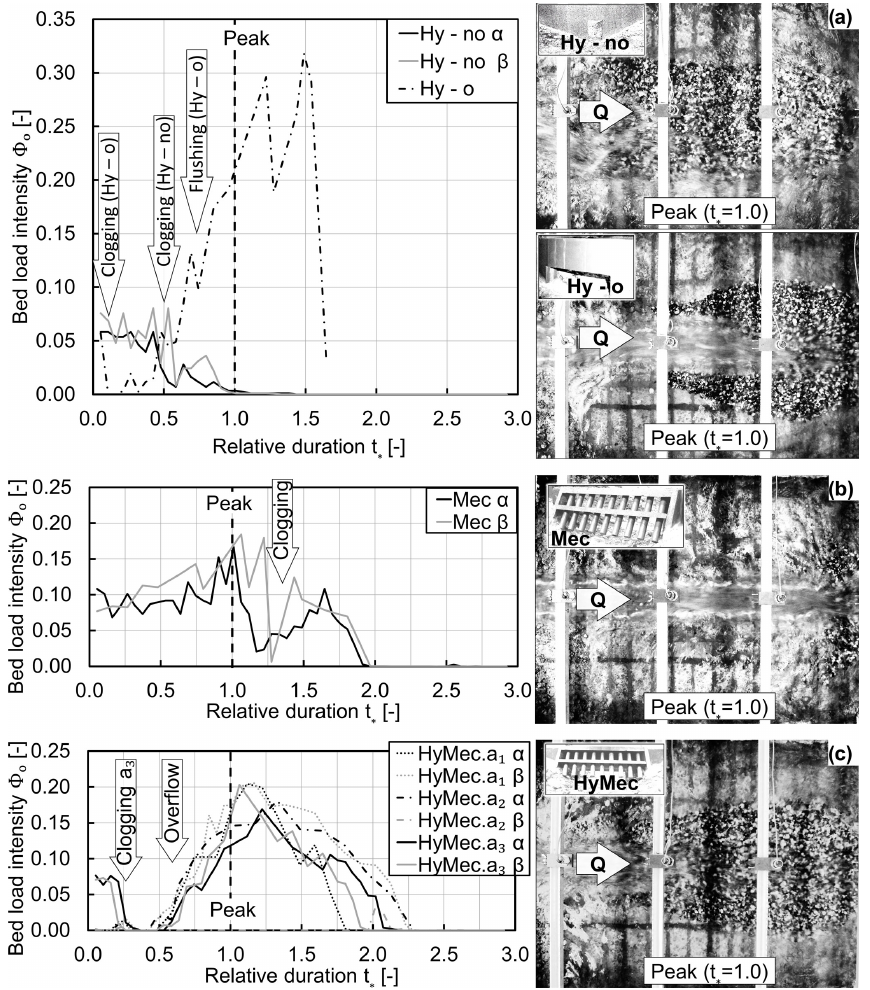
Figure 8. The outflowing bed load transport intensity (cid:56) o as a of function the relative time t ∗ and for the two repetitive tests α and β . (a) for hydraulic control without barrier overflow (Hy-no) and with barrier overflow (Hy-o); (b) for mechanical control by the bar screen (Mec); and (c) for combined deposition controls (HyMec), i.e. the combination of hydraulic barrier with varying opening heights a 1 , 2 , 3 and upstream superposed bar screen. The top view pictures at the right show the sediment deposits at the flood peak of the α